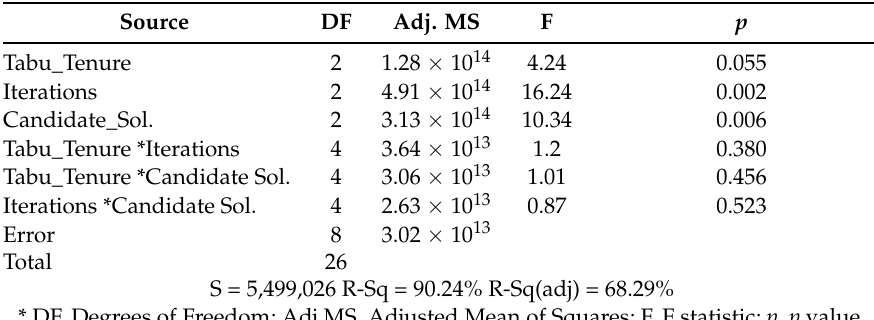
Table 7. ANOVA for total planning cost in large